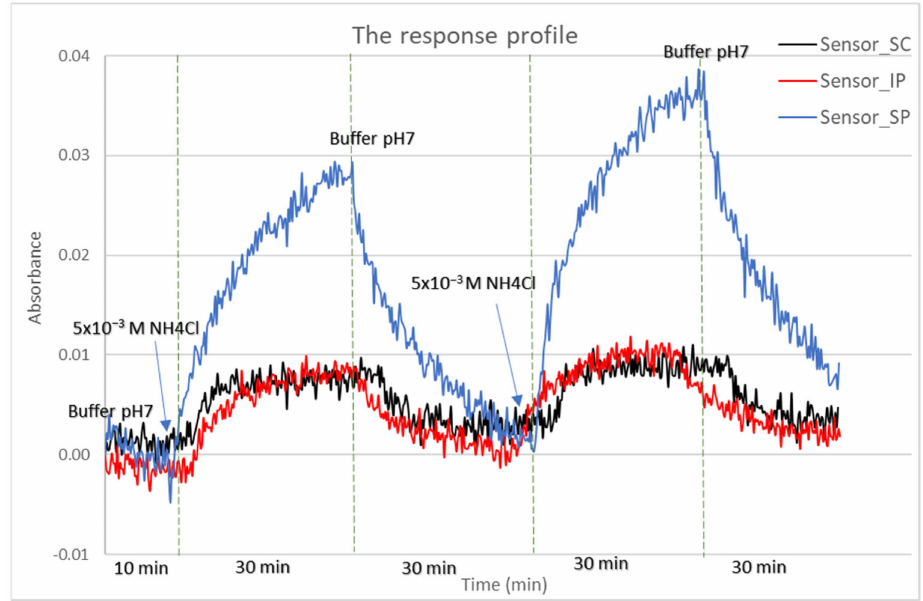
Figure 7. Response time of sensor layers (SC, IP, SP) in the presence of NH 4 Cl (5 × 10 − 3 M), pH